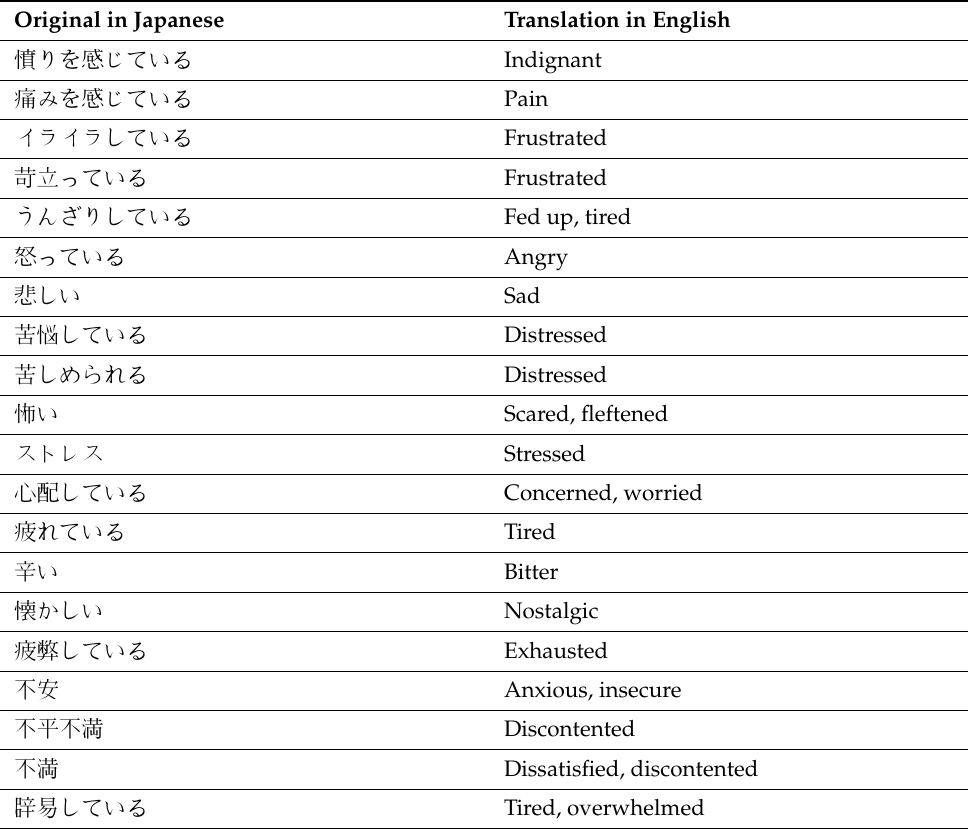
Table 2. Examples of negative